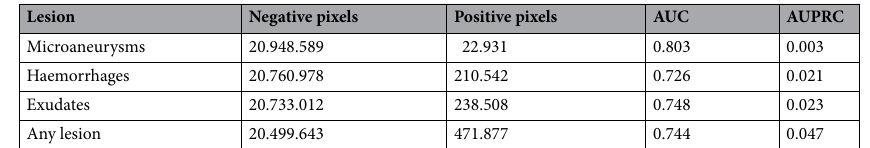
Table 4. Resulting AUC and AUPRC scores when using the attention weight of a patch as a binary predictor of lesion presence for each pixel. We report scores against different lesion types individually, as well as all lesions combined. Results are produced using images of the IDRiD dataset for which pixel-level lesion annotations are